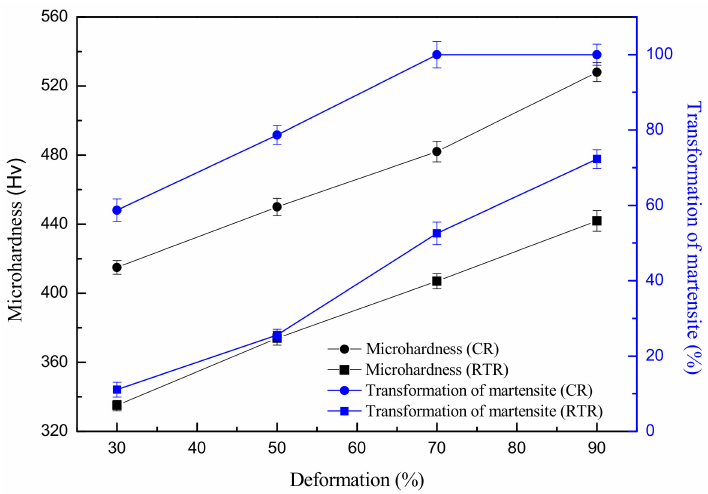
Figure 2. Relationship of the volume fraction of the martensite and microhardness with deformations at different temperatures (the data of CR is from